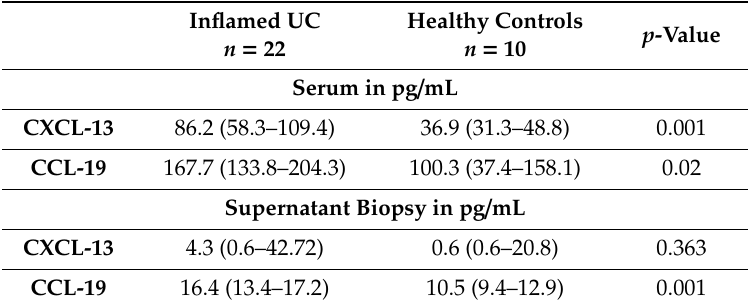
Table 5. Values of CXCL-13 and CCL-19 in the serum and supernatant of patient with ulcerative colitis at first presentation, compared with healthy controls (in pg /